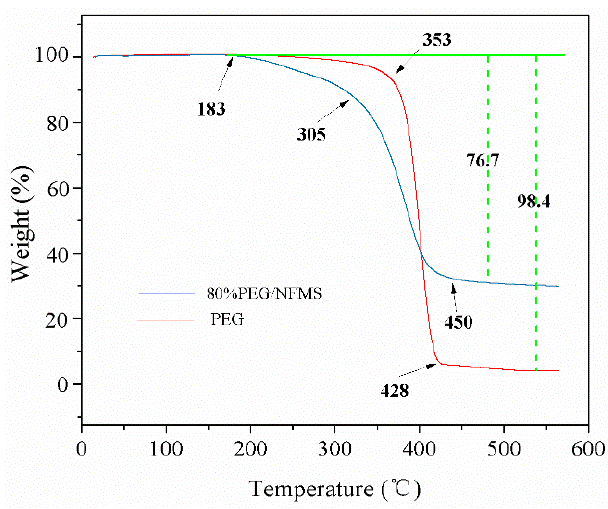
Figure 7. Thermal gravimetric analysis (TGA) curves of pure PEG and 80 w% PEG/NFMS.